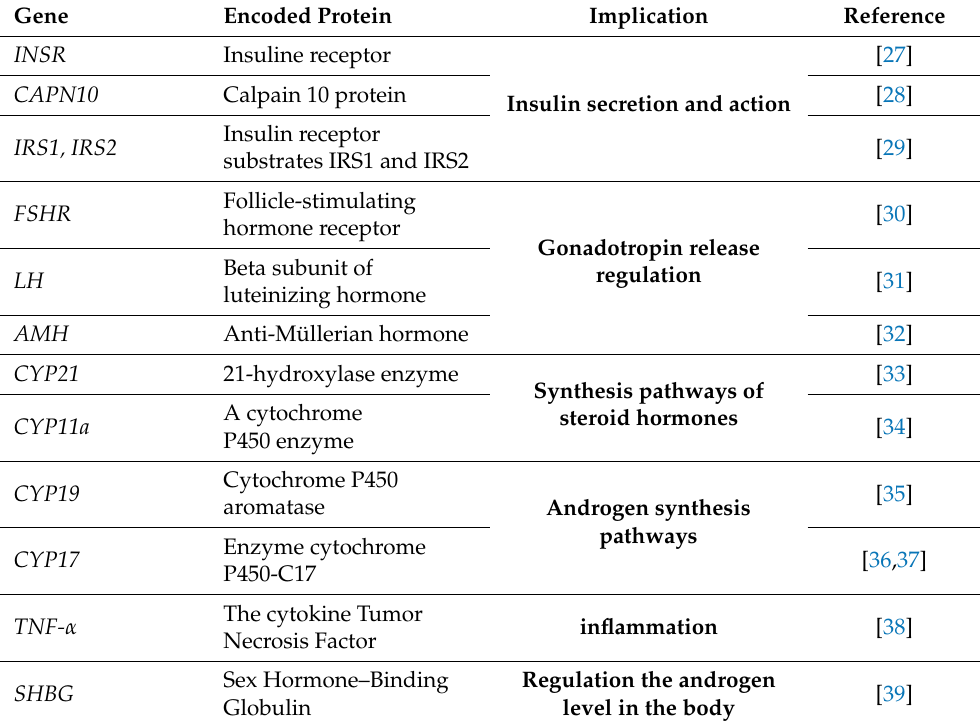
Table 1. Pivotal genes that have been involved in PCOS